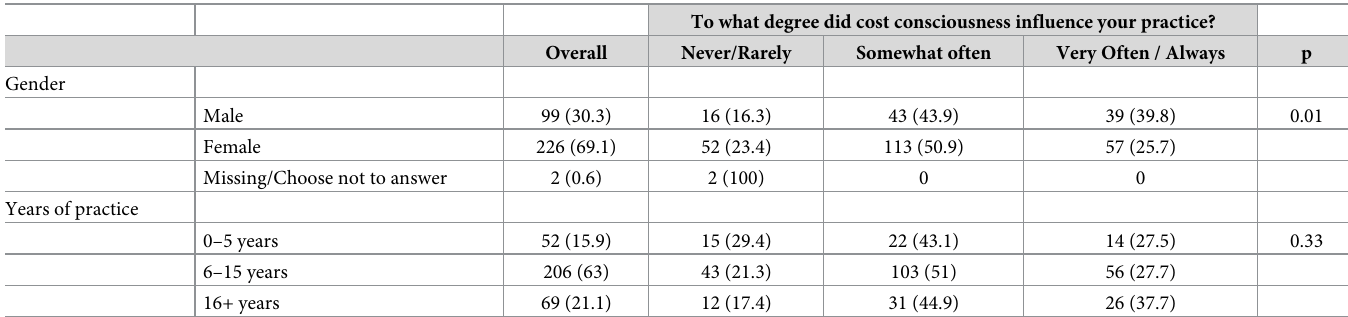
Table 1. Demographics and self-reported cost-consciousness.